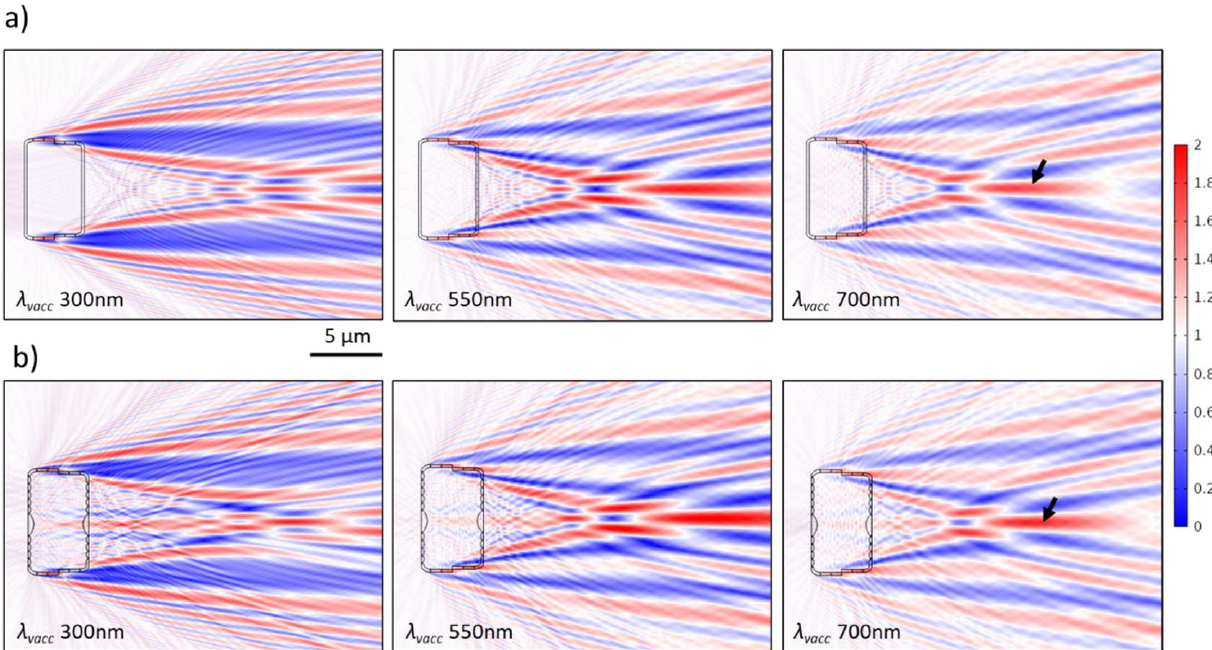
Figure 11. The interference pattern of CS long5,frustule ( a ) and CS long3,frustule ( b ), which represent a complete frustule consisting of CS long,5 or CS long,3 , respectively, immersed in water at different λ vacc . With increasing λ vacc , the diffraction-driven focusing fringes that appear outside the CSs move toward them. The hypovalve (of the same structure) is slightly smaller than its epivalve. The black arrows indicate what seems to be a PJ.